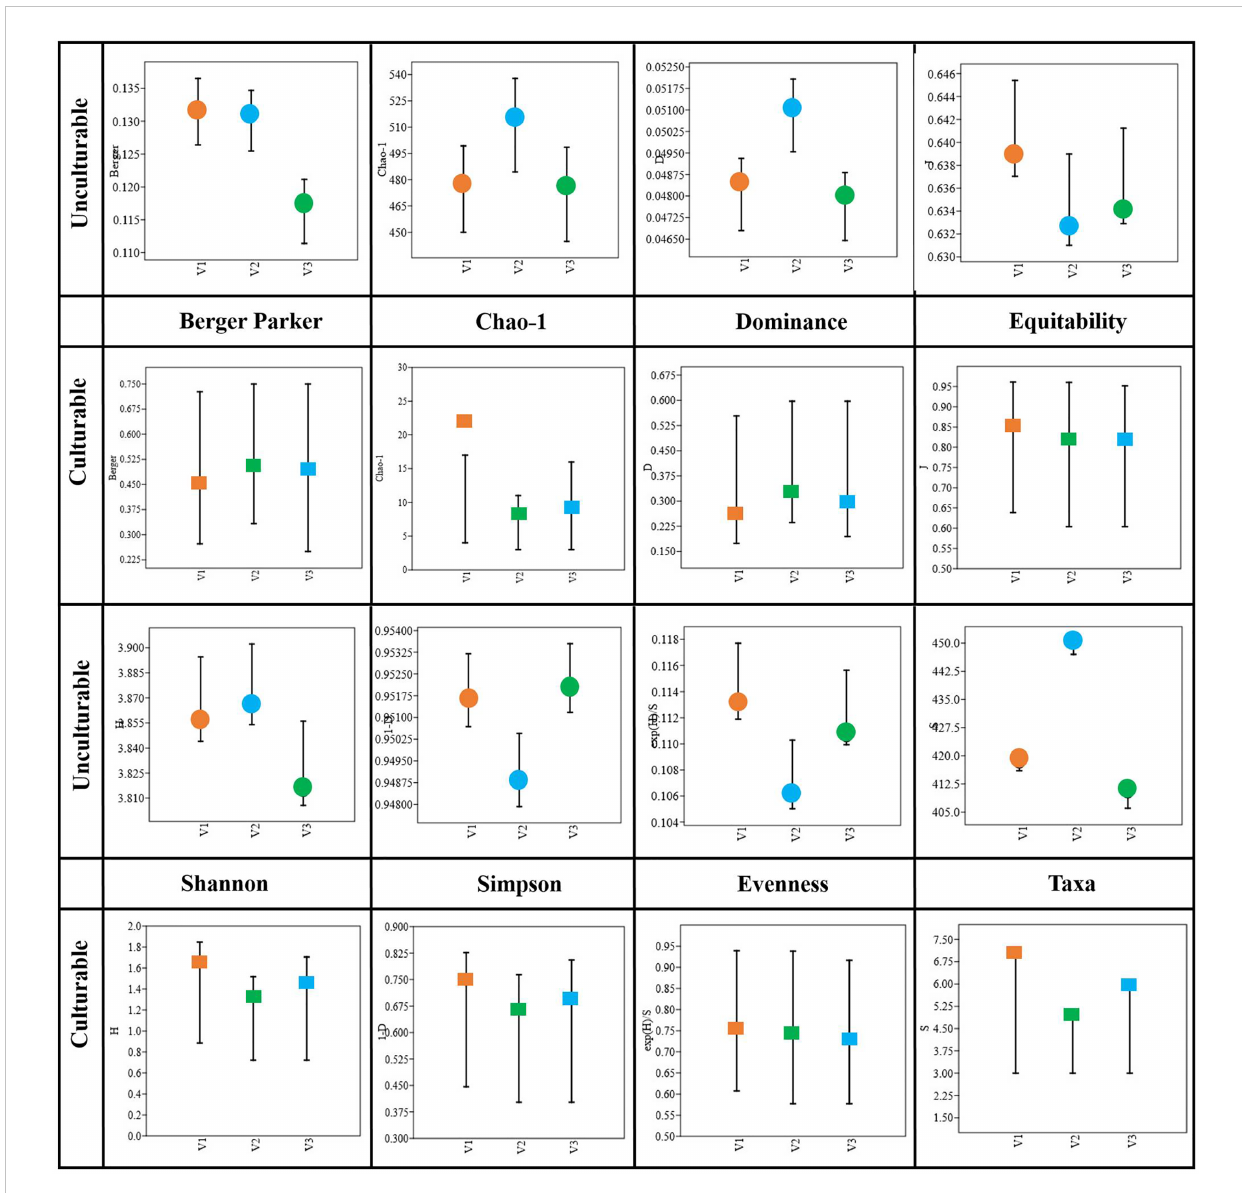
FIGURE 7 Diversity indices of bacterial taxonomy in heat S (GW322) and heat T (HD3298 and HD3271) wheat